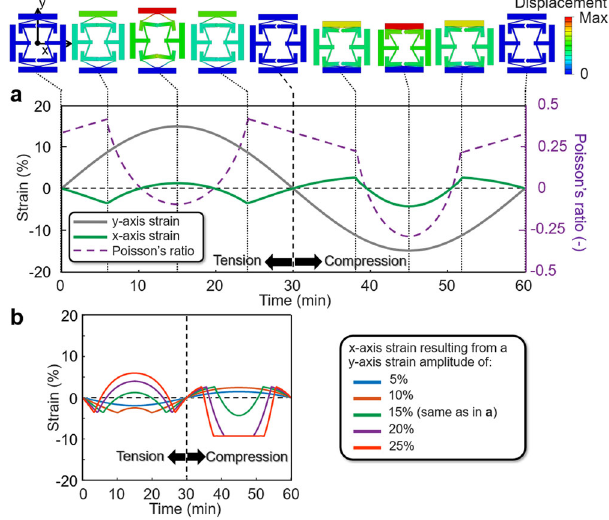
Fig. 3 Finite-element-analysis (FEA) generated plots that demonstrate Design I ’ s sequential deformations given Te fl on material properties. a Plot showing how 9 still frame images of the Design I cell correspond with the cell ’ s sequential deformations for a sinusoidal y -axis input strain with an amplitude of 15%. b Plot showing the cell ’ s x -axis strain responses to fi ve different y -axis sinusoidal loading amplitudes ranging from 5% to